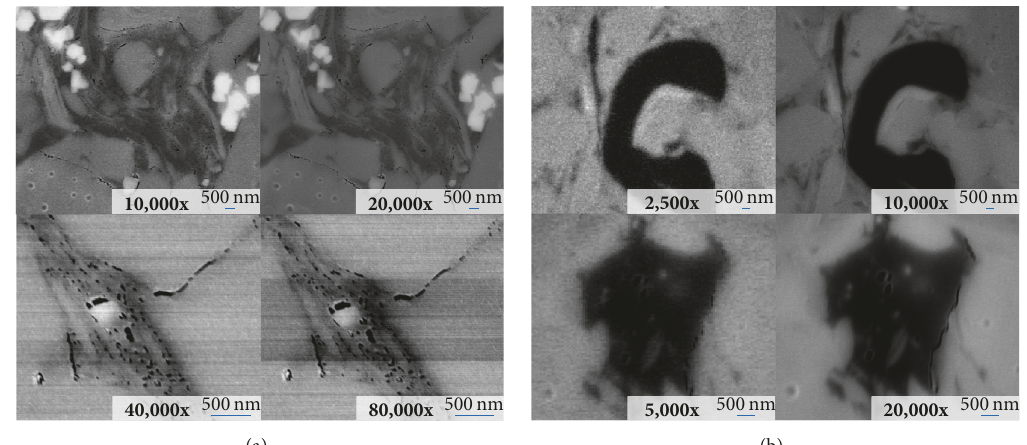
Figure 3: Dispersed OM pervaded by porosity in sample NJ-001 (a) and almost no OM porosity in sample NJ-019 or NJ-023 (b).